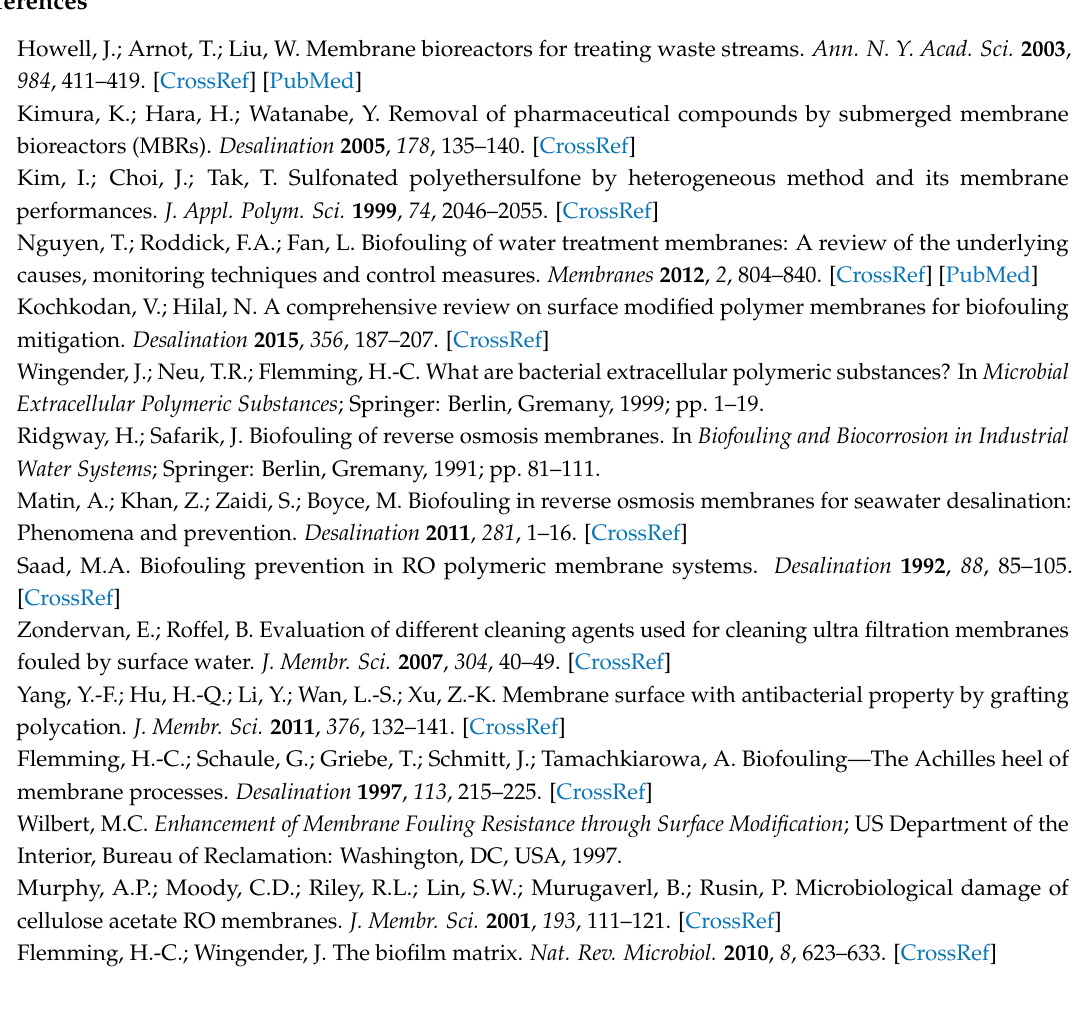
Figure S1. TGA and DTGA thermograms for M1 neat PES (a), M8 PES/GO (b) and TGA thermograms overlay for selected PES/GO and neat membranes. Figure S2. DSC curve overlay for selected PES/GO and neat membranes. Figure S3. Viscosity as a function of shear rate plotted for selected casting solutions for neat PES and selected PES/GO membranes. Figure S4. Graph showing flux readings for filtration of real TSE for selected fabricated membranes and the UF commercial membrane (a) and the normalized flux for each of the three membranes calculated as the final reading at the end of the filtration over the initial reading at the beginning of the filtration test. Figure S5. Membrane fluxes before and during incubation with real TSE at different time